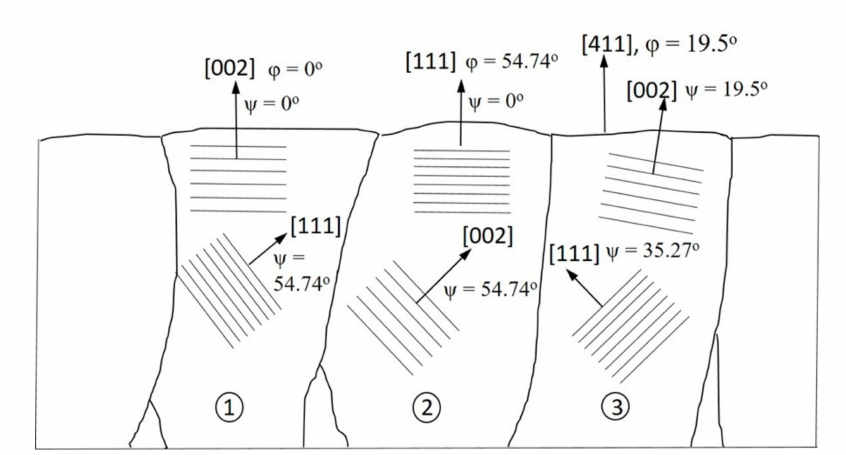
Figure 1. Schematic diagram of typical grain orientations showing the definitions of ϕ and ψ relative to the crystal structures and sample surface. The ϕ angle is the angle of tilt away from the [002] direction in the crystal, whereas ψ is the common di ff raction vector, and is perpendicular to the surface in a Bragg-Brentano di ff raction